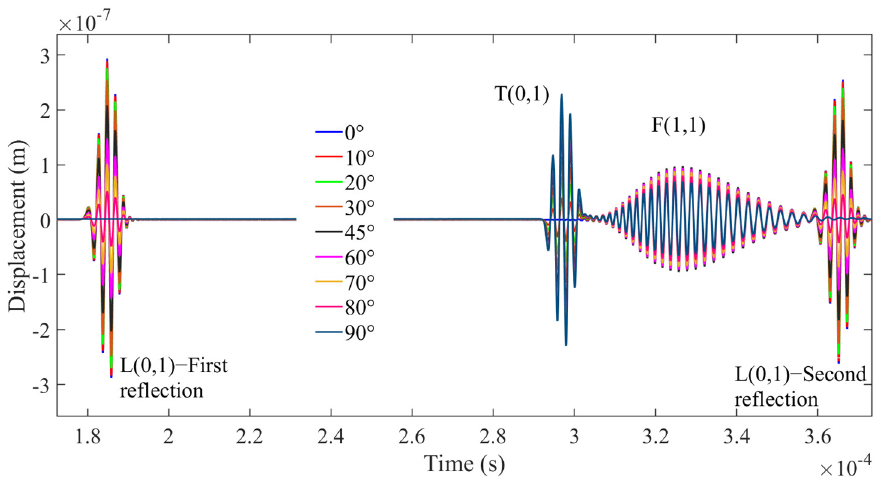
Figure 5. Signals acquired at different angles of excitation (0°–90°).